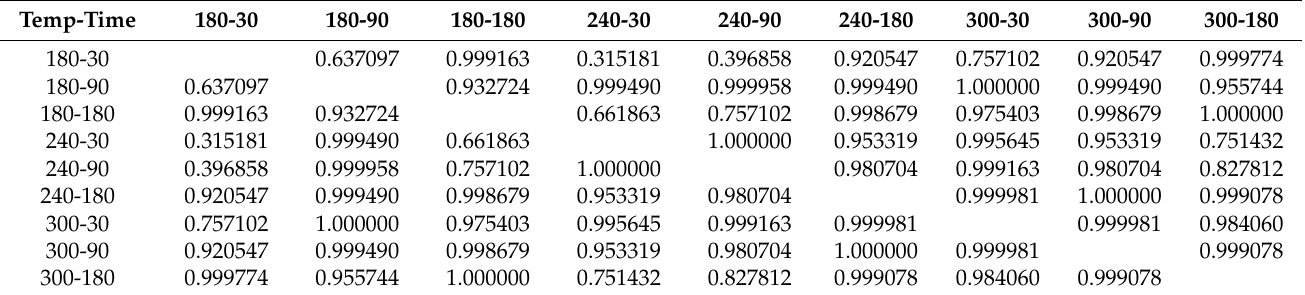
Table A14. Two-way analysis of variance (ANOVA) with post hoc Tukey test for S , a bold font signifies a statistically significant difference ( p <